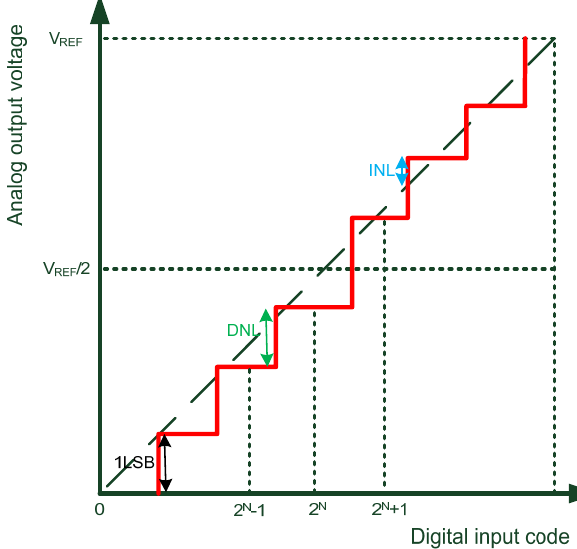
Figure 10. Illustration of DNL and INL error (Adapted from